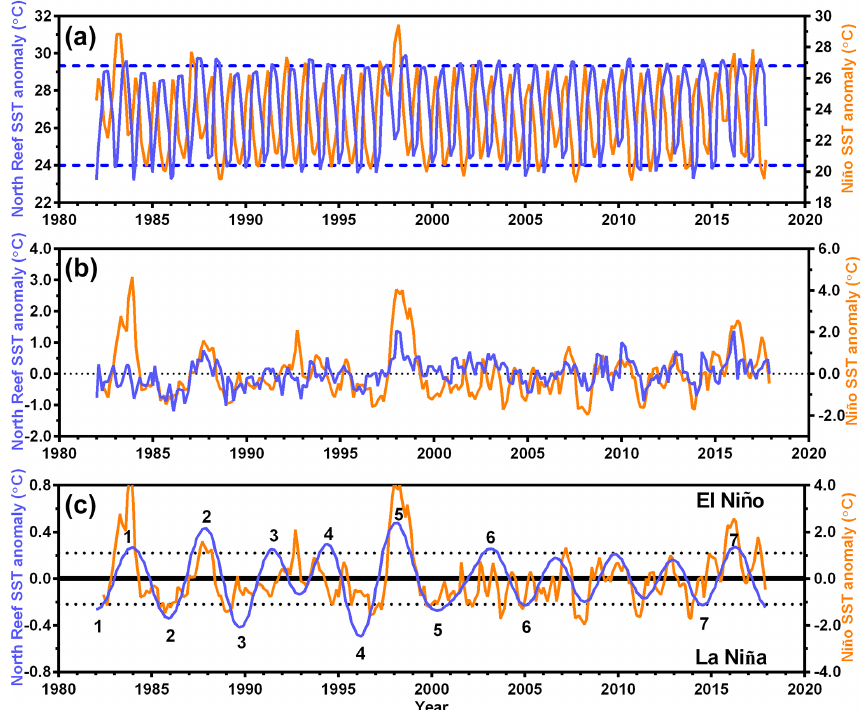
Figure 8. Relationship between Ninõ 1 + 2 SST and the North Reef SST: (a) the North Reef SST (blue line) compared with Ninõ 1 + 2 SST (yellow line); a clear time lag exists. (b) SST anomalies of two areas; the lag is removed by forwarding the North Reef SST anomalies for 3 r months. (c) The North Reef SST anomalies were performed with 3–7 years of bandpass filtering, consistent with Ninõ 1 + 2 SST anomalies; the dashed lines show the calculated threshold limits (1 σ ) for ENSO activity in the North Reef. El Ninõ and La Niña events are represented by positive and negative SST anomaly values,